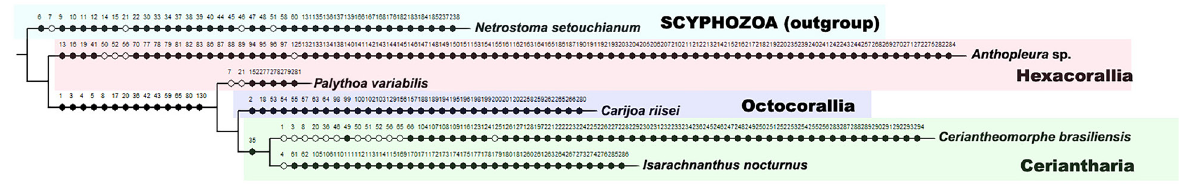
Figure 2. Phylogenetic reconstruction based on characters of feeding